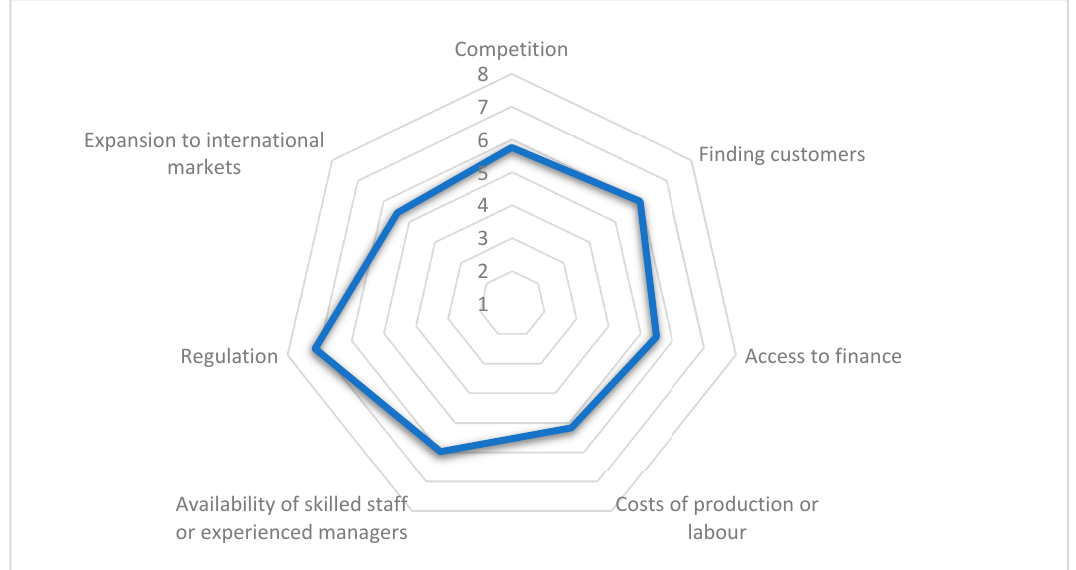
Figure 5. Responses to the question how pressing specific problems are; 1 = not pressing, 10 = extremely pressing (means).